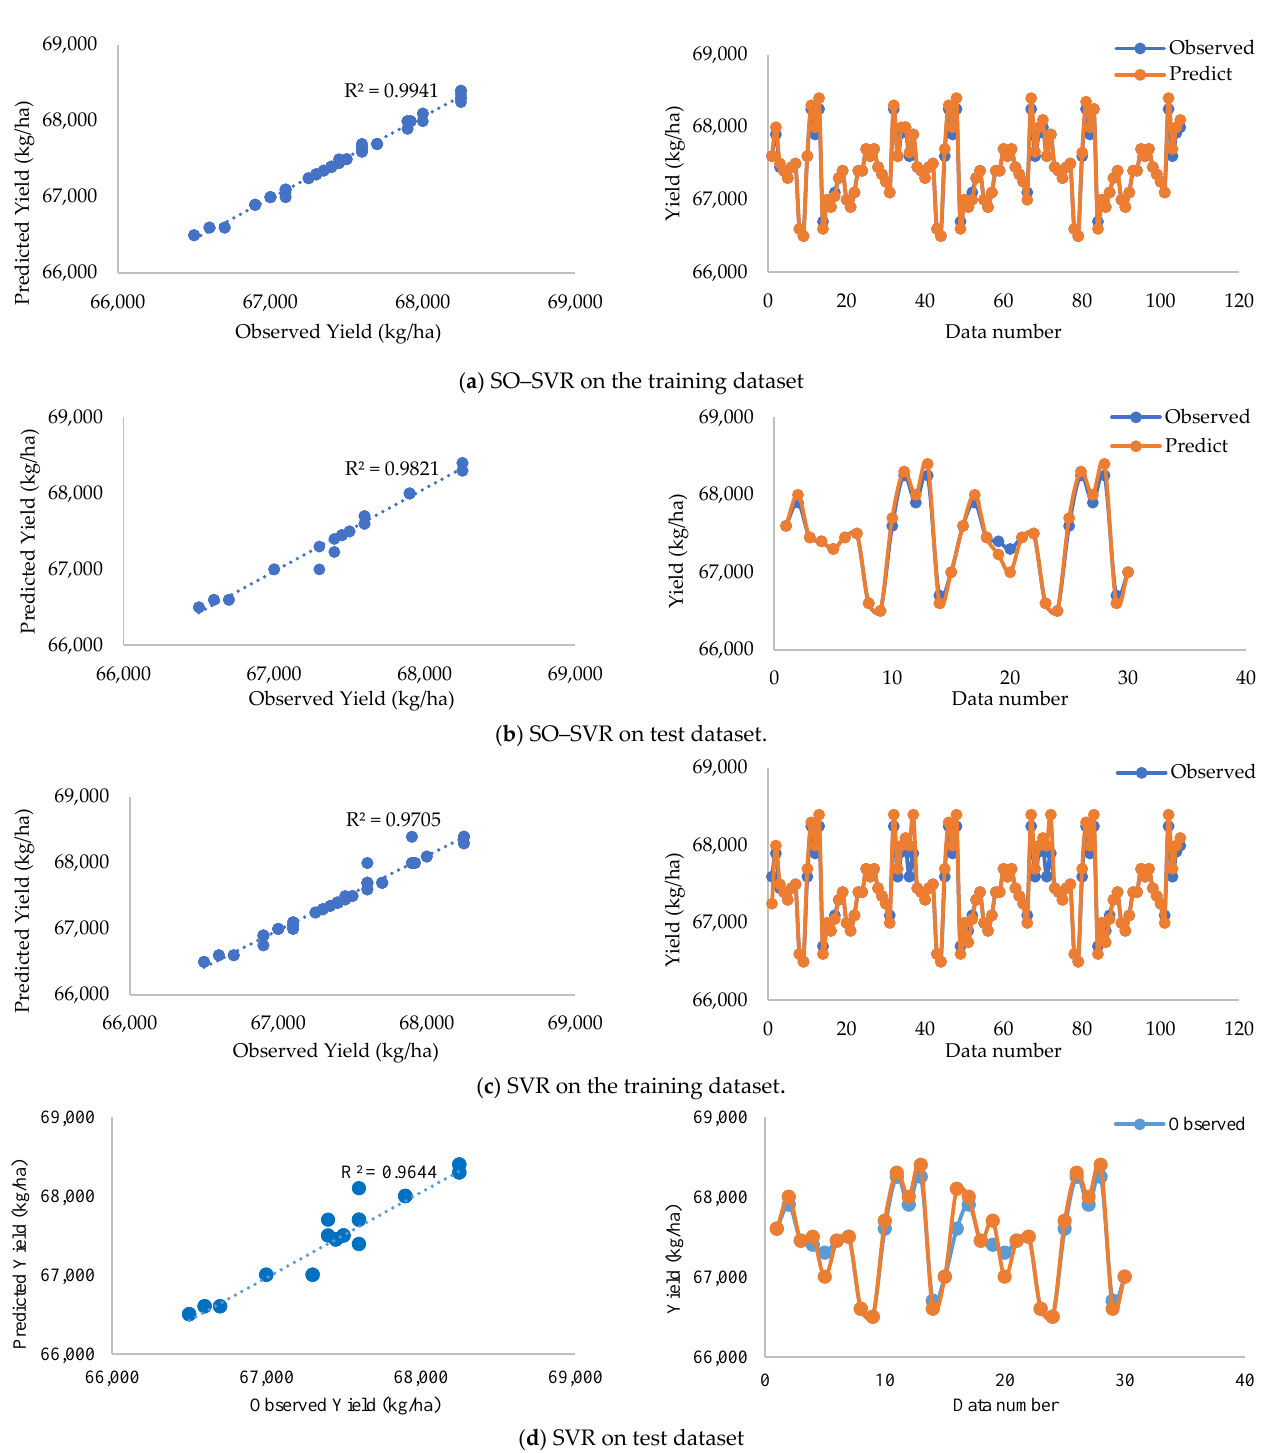
1 Table 9. Evaluation of hybrid models in WP estimation. Model